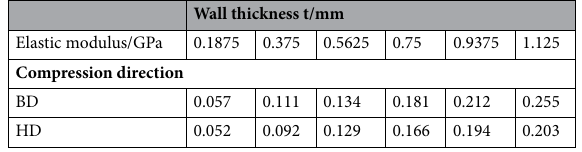
Table 5. Elastic modulus of Gyroid structures with different wall thickness.